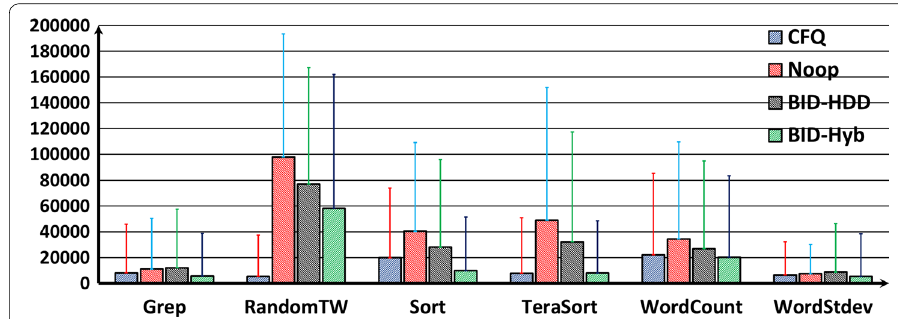
Fig. 16 Avg distance (no. of cylinders or tracks) per disk arm movement